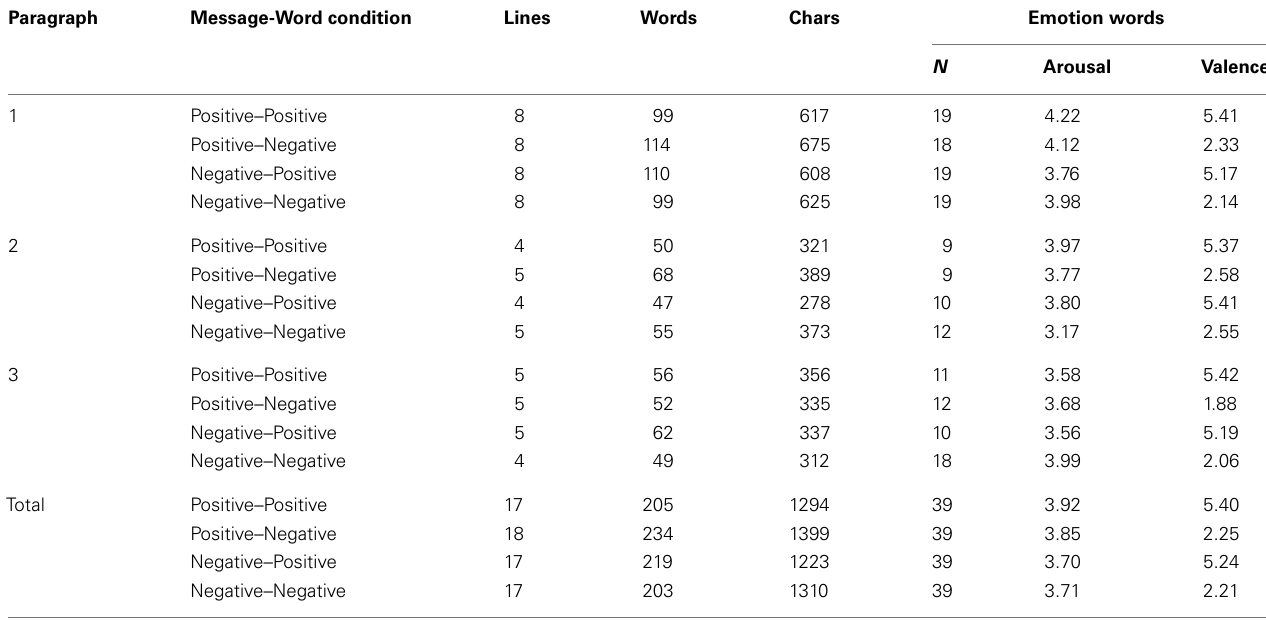
Table 1 |Text characteristics of car